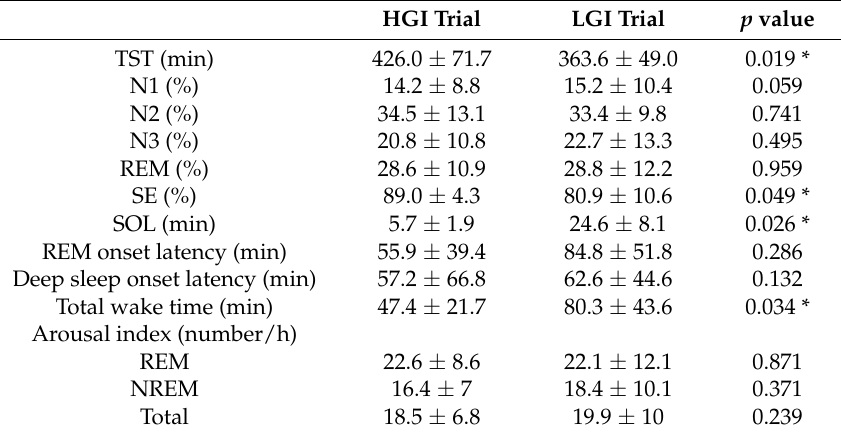
Table 1. Sleep-related parameters.